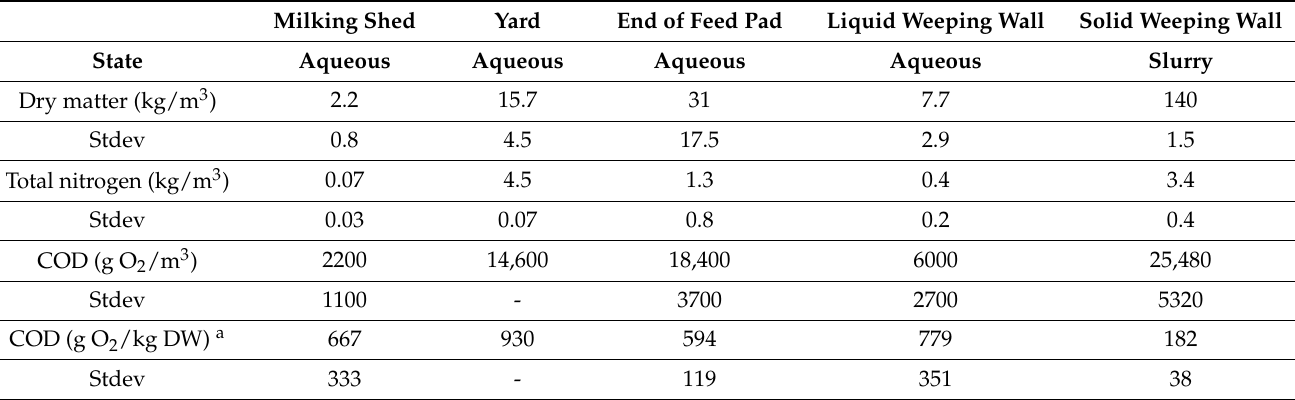
Table 4. Chemical analysis of effluent at different stages of the milking and treatment systems.